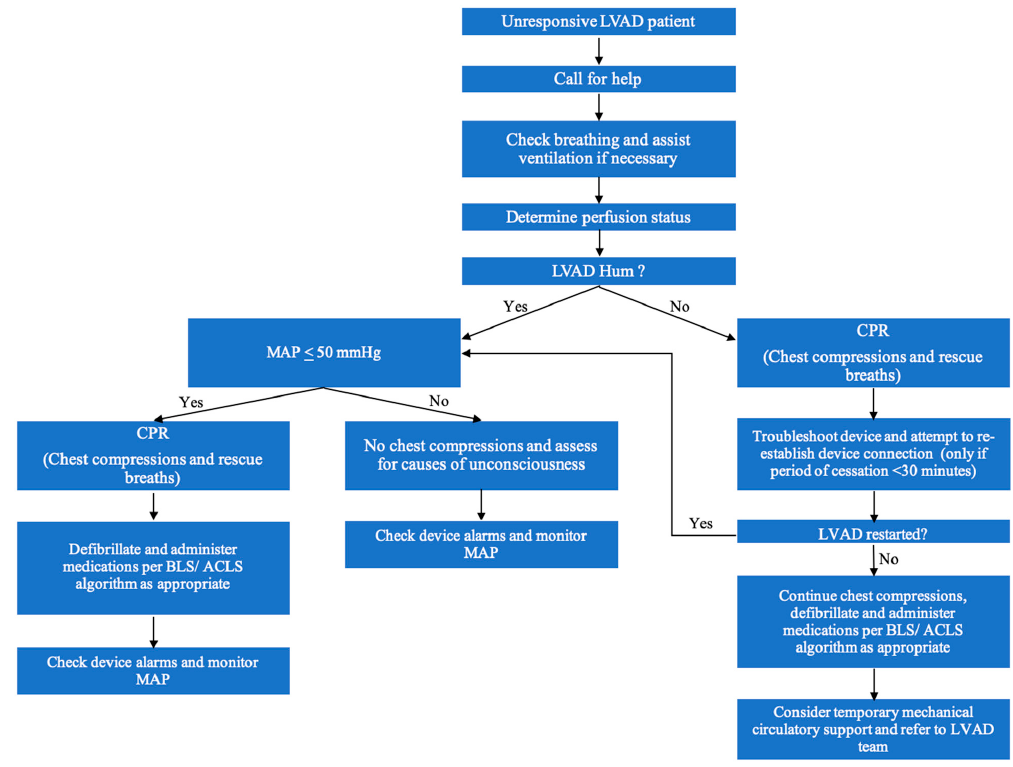
Figure 3. Approach to an unconscious patient with an LVAD.